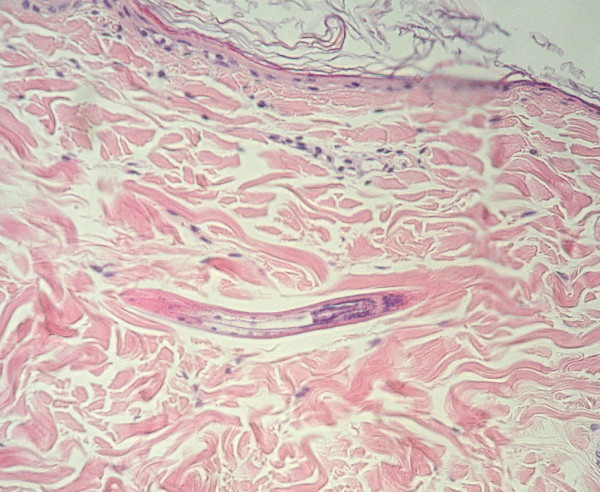
Larvae of A. caninum crossing dog skin in vitro. Longitudinal section, HE-staining (400X magnification).